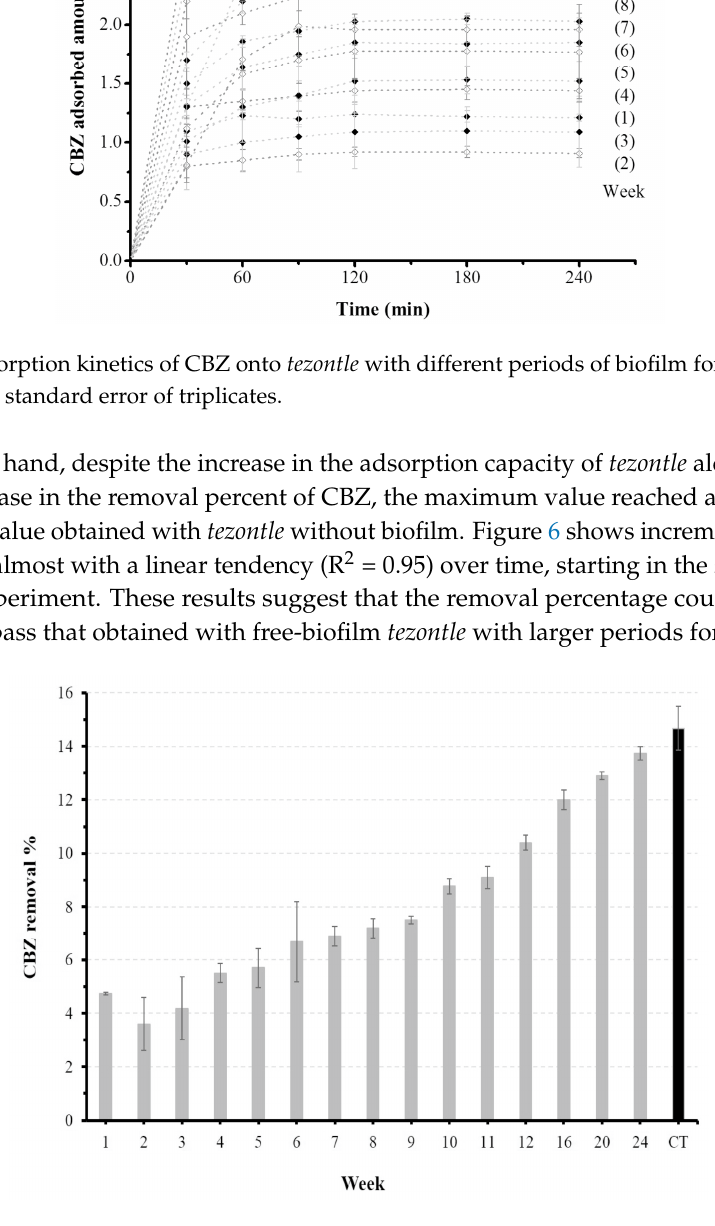
Figure 6. CBZ removal percentage (mean ± standard error) by tezontle with different periods of biofilm formation and clean tezontle (CT).